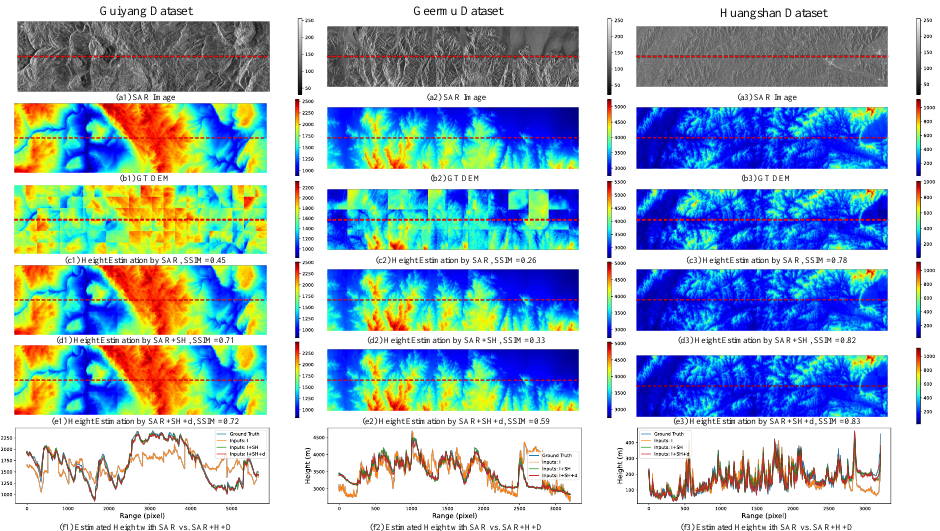
Figure 6. Height estimation result of a single SAR image based on sparse height information and PDNAS for Unet in three datasets. The downsampling factors of SH are 96 × 96. ( a1 – a3 ) are the SAR images, ( b1 – b3 ) are the ground truth height map. ( c1 – c3 , d1 – d3 , e1 – e3 ) are the estimated height map with SAR, SAR+ SH , SAR+ SH + d respectively. Elevation lines along the range directions with a fixed middle azimuth value marked by red dash lines in ( a1 – e1 ), ( a2 – e2 ), ( a3 – e3 ) are plotted in ( f1 – f3 )